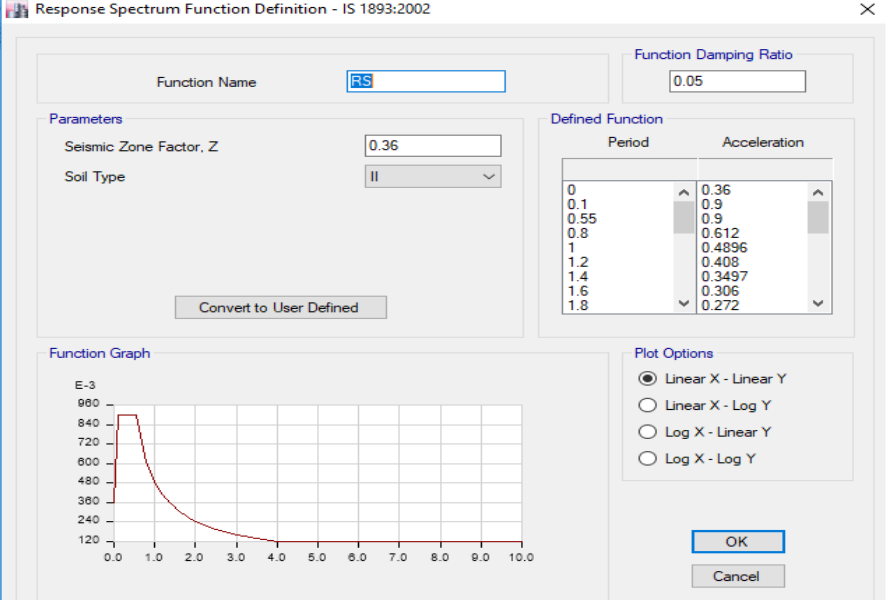
Figure 5. Response spectrum function